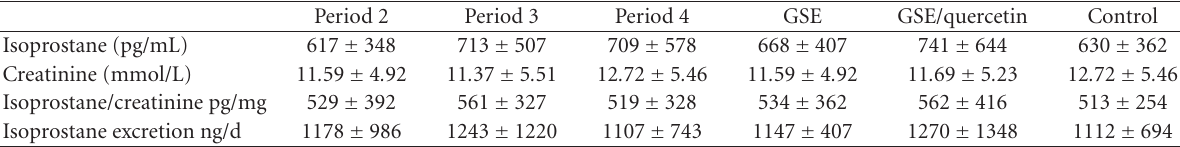
Table 6. E ff ect of GSE and GSE/quercetin on urine isoprostane (iso PGF2 α ). N = 35, mean SD.